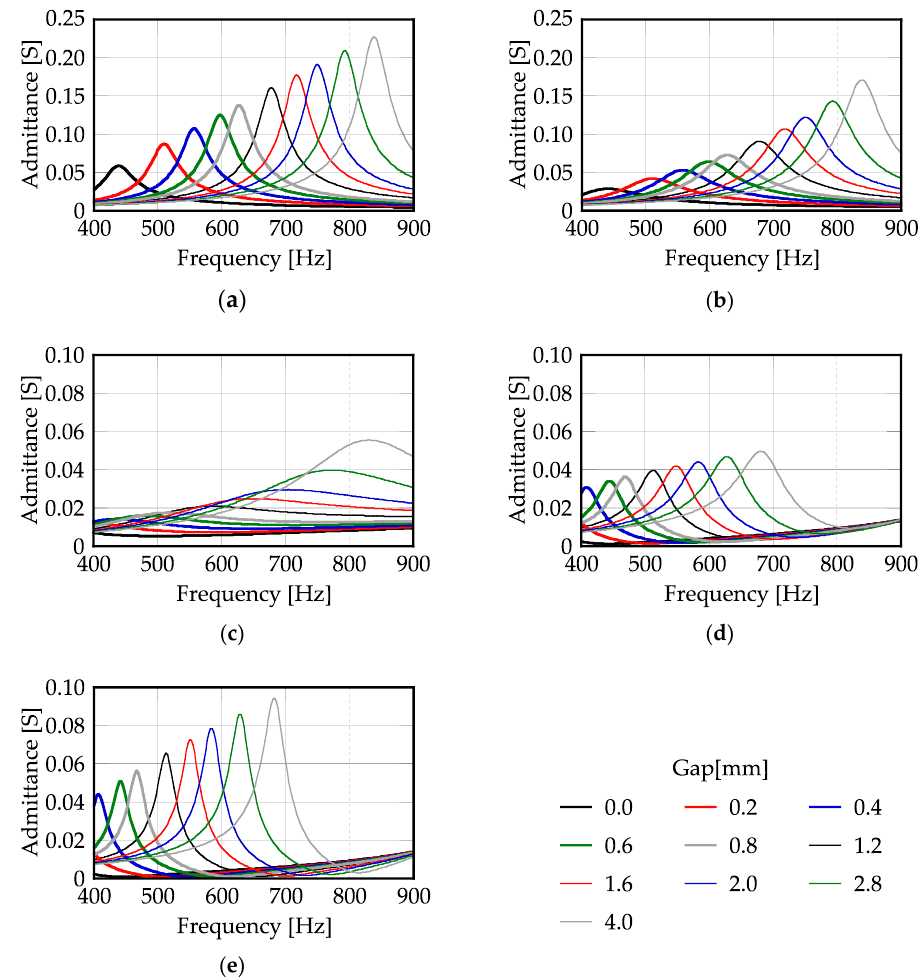
Figure 18. Frequency characteristics of admittance respect to gap in the pair number 1. ( a – e ) represent the characteristics for various load resistances. ( a ) ∞ [Ω] (Open circuit). ( b ) 1 kΩ. ( c ) 100 Ω. ( d ) 10 Ω. ( e ) 0 Ω (Short circuit).